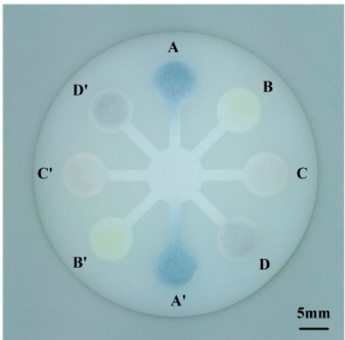
Figure 5. Multi-assay of phenols (A), flavonoids (B), antioxidant capacity (C), and tyrosinase inhibition effect (D) in fruit juice. (For interpretation of the references to color in this figure legend, please refer to the web version of the article.).